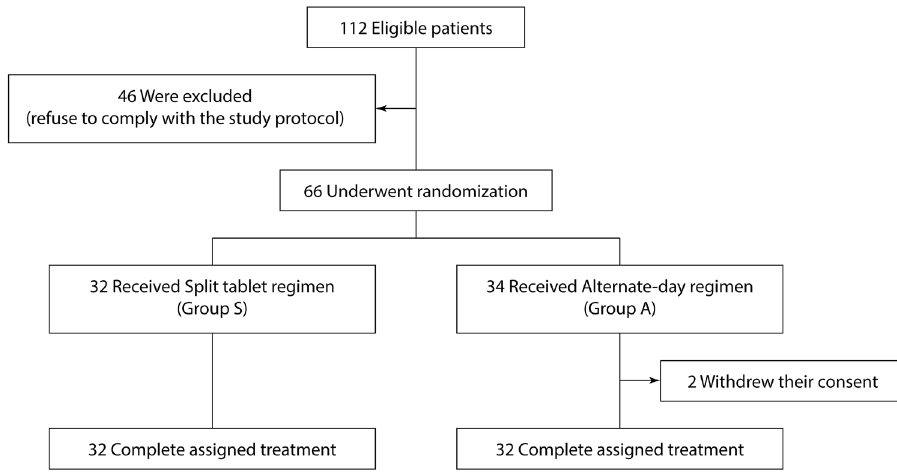
Figure 1. Enrollment, randomization, and assigned treatment.